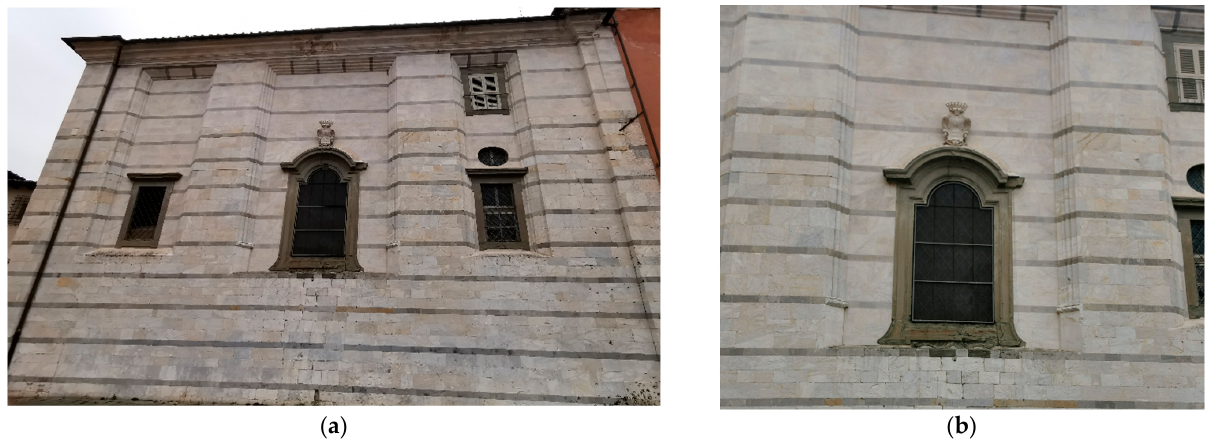
Figure 27. The actual aspect of the rear façade (June 2021): ( a ) global view; ( b ) detail.